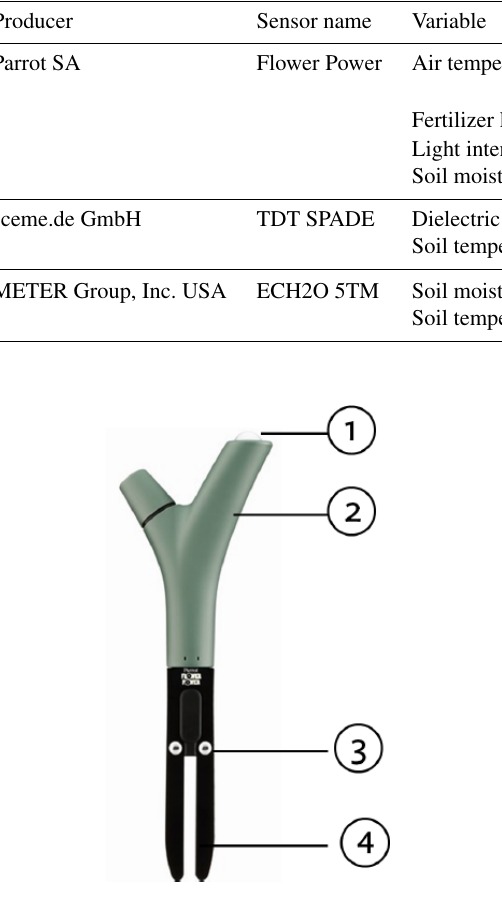
Figure 1. Schematic of the FP sensor: (1) light intensity, (2) ambient temperature, (3) fertilizer level, and (4) soil moisture sensor (Parrot,